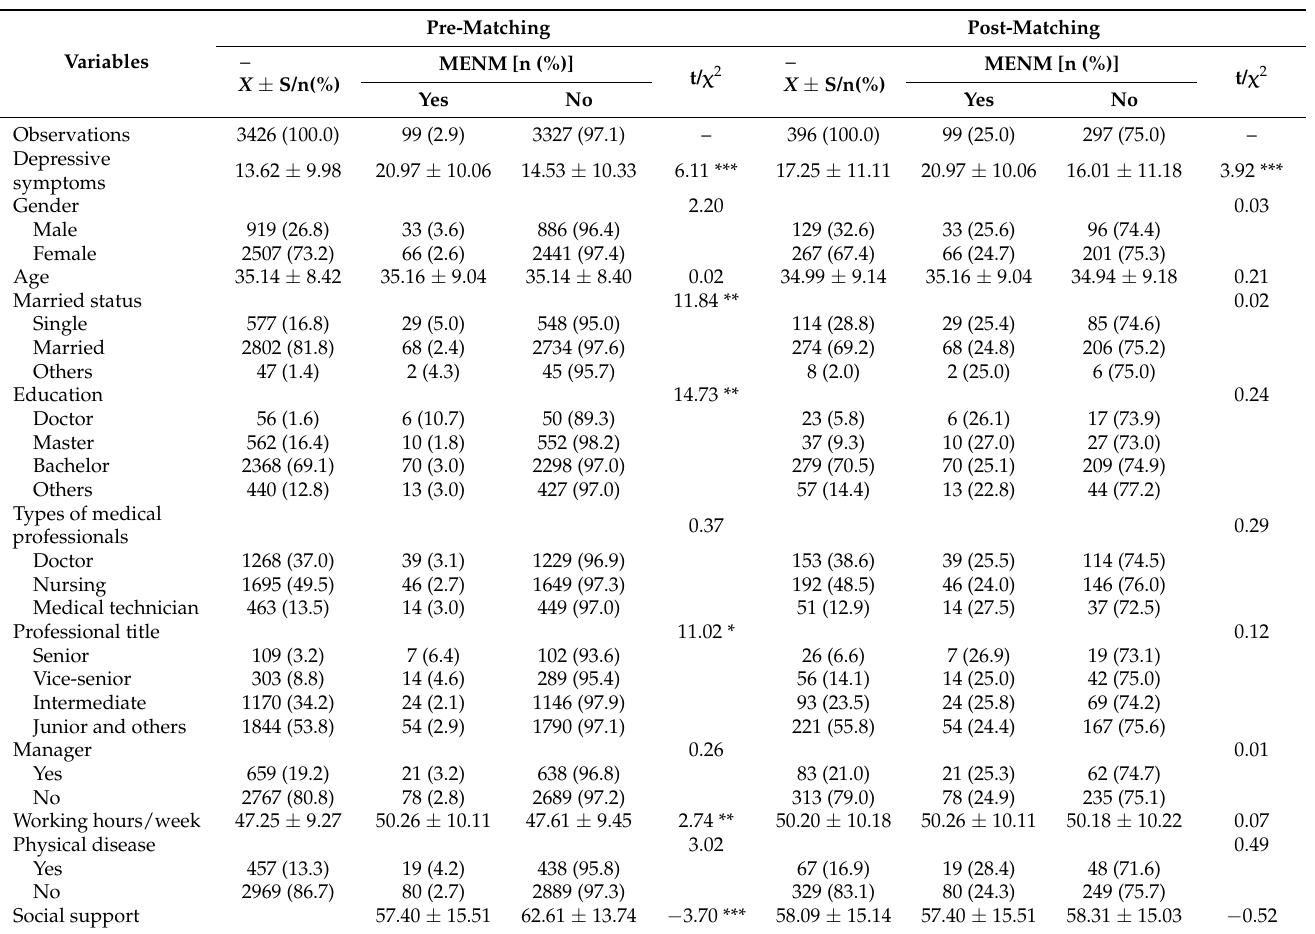
Table 1. Description of the sample and single analysis for the factors associated with MENM among medical professionals before and after propensity score matching.